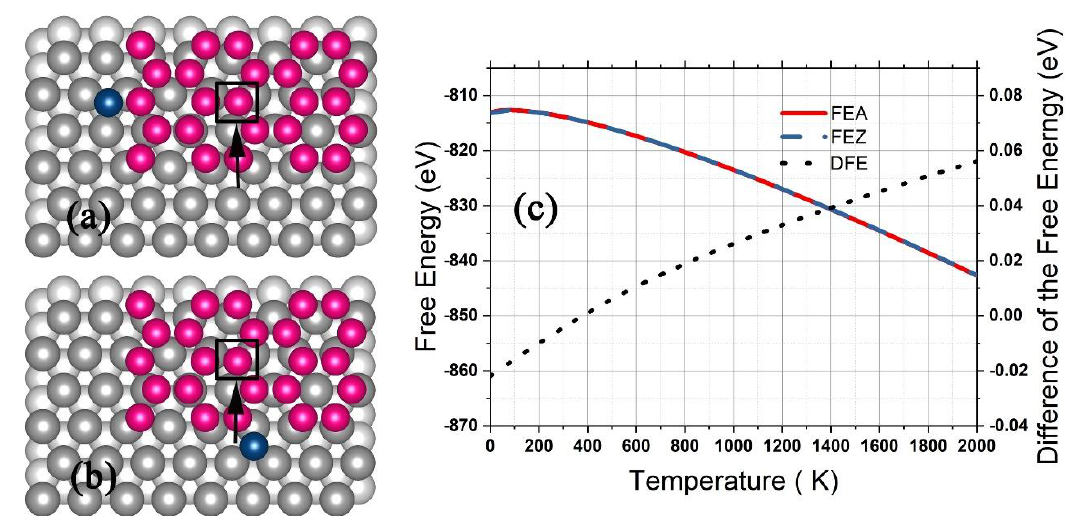
Figure 8. A silicene grain of four silicon hexagons on the Ag (111) surface with a deposited Si atom adhered to the zigzag ( a ) or armchair edge ( b ). The free energy for the zigzag adherence and armchair adherence and the difference are shown in ( c ).